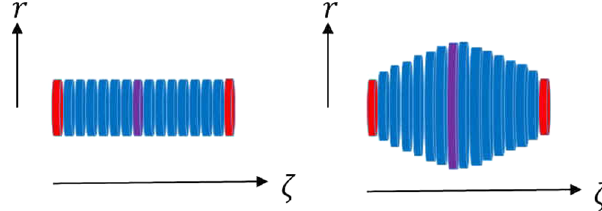
FIG. 6. (Left) bunch initially with uniform radius; (right) the center slice (purple) will expand more than the end slices (red) due to a higher space-charge force.